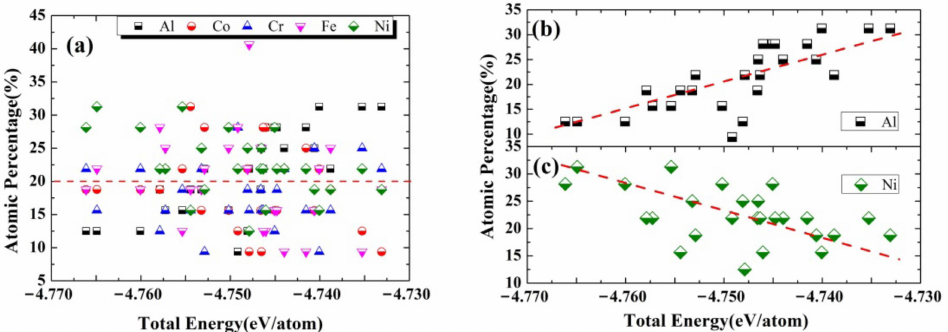
Figure 3. The total energy of HEA − reinforced AMCs against the chemical compositions of ( a ) all constituent alloy elements, ( b ) Al, and ( c ) Ni at the Al/AlCoCrFeNi